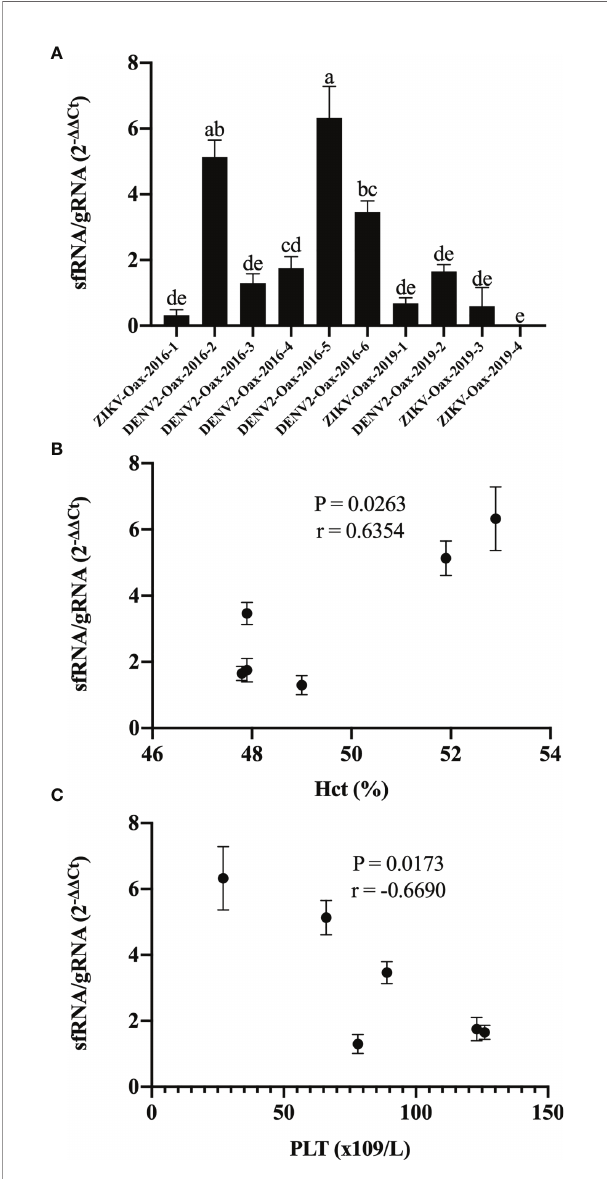
FIGURE 6 | Accumulation of subgenomic fl aviviral RNAs (sfRNA) in HFF- 1 infected with Flavivirus isolates varies and correlates with infection reduction and warning signs. (A) RNA from HFF-1 cells infected with the Flavivirus isolates was used to evaluate the sfRNA relative accumulation by the 2 - DD Ct method by RT-PCR; letters indicate distinct groups based on the post-hoc statistical comparison (p < 0.05). Groups without a common letter are signi fi cantly different. Data are presented as the mean ± SD; n = 2. Spearman ’ s correlation was calculated between sfRNA/gRNA 2 − DD Ct hematocrit percentage (B) and platelet count (C)